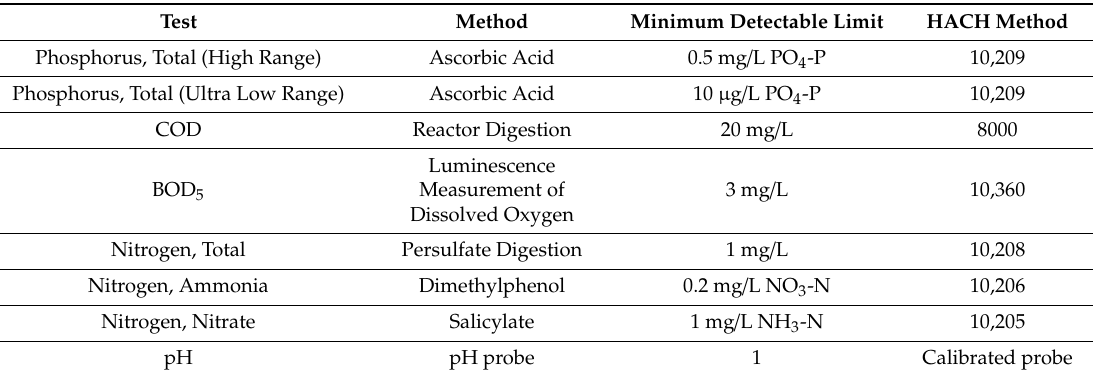
Table 5. Testing methods.